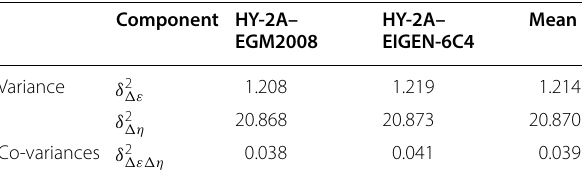
Table 6 Comparing the initial and improved versions of HY-2A-derived gravity anomalies (unit: